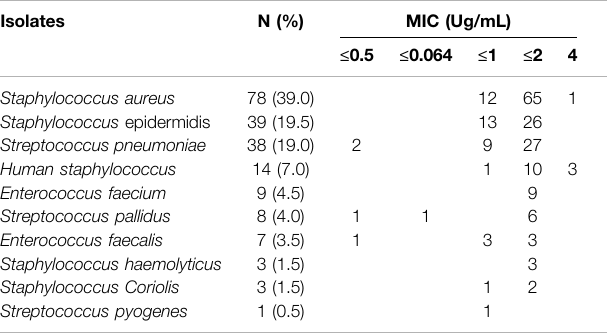
TABLE 5 | The species and MIC distribution of bacterial strains isolated from patients before linezolid treatment (n = 200).